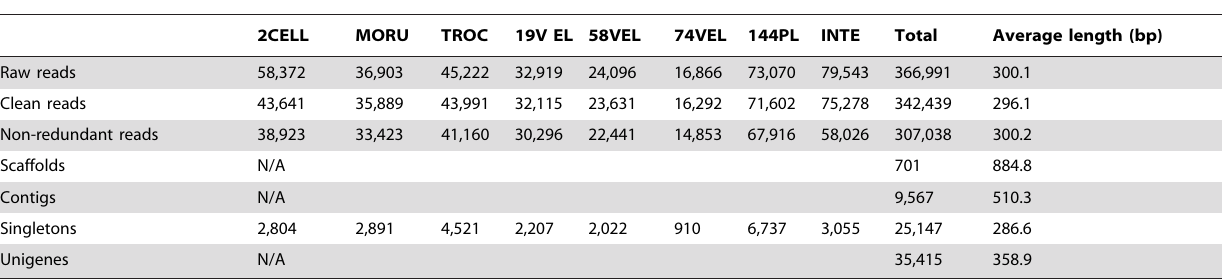
Table 1. Summary of the sequencing and assembly